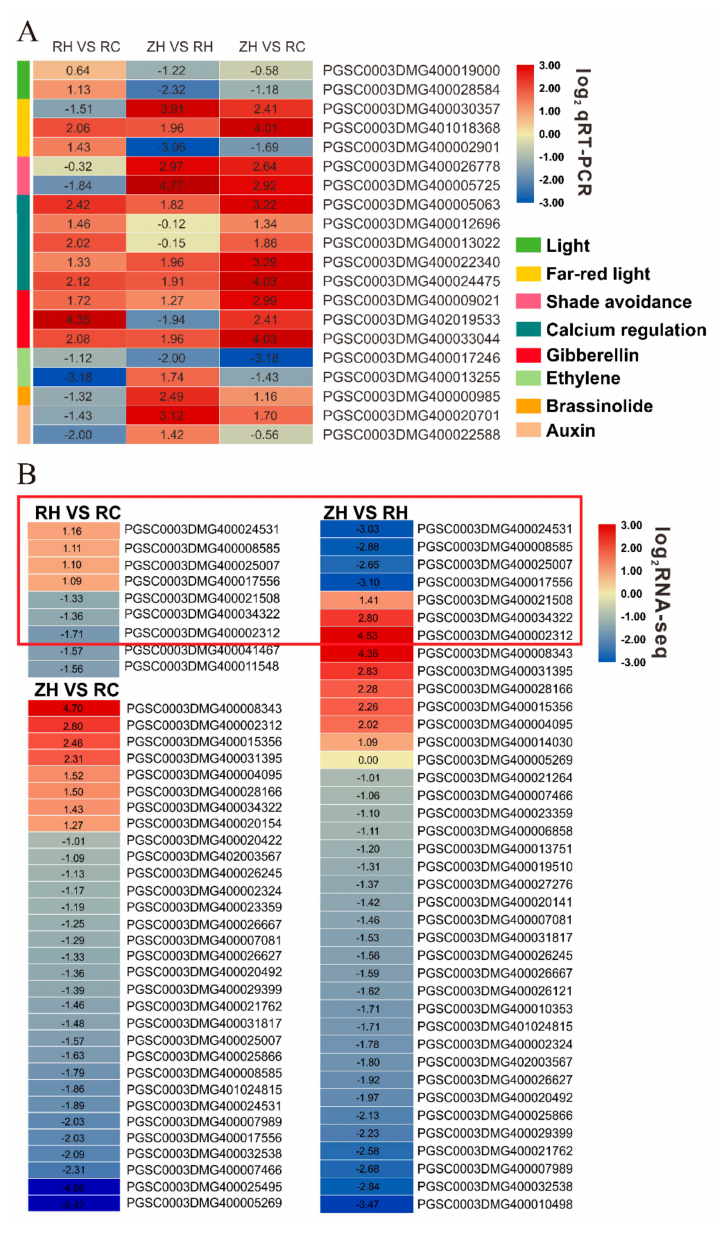
Figure 12. DEGs analyzed in photosynthesis and plant hormones using a heatmap. ( A ) We measured the levels of hormones, light, shade avoidance and calcium regulation in di ff erent treatments by qRT-PCR. ( B ) Photosynthesis-related genes were analyzed through the transcriptome in RH vs. RC and ZH vs. RH. The di ff erence in red indicates that both expressed DEGs. Values represent the mean ± S.E. ( n =